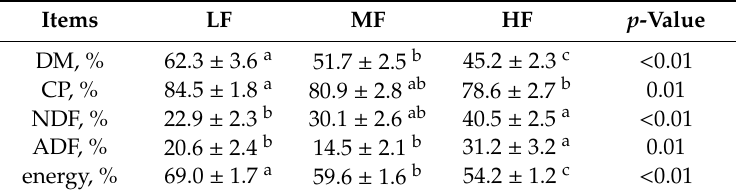
Table 3. Total digestive tract nutrient digestibility coe ffi cients of low- (LF, F / C = 35:65), medium- (MF, F / C = 55:45) and high-fiber (HF, F / C = 80:20) diets fed to adult donkeys with di ff erent forage / concentrate ratios (F / C).